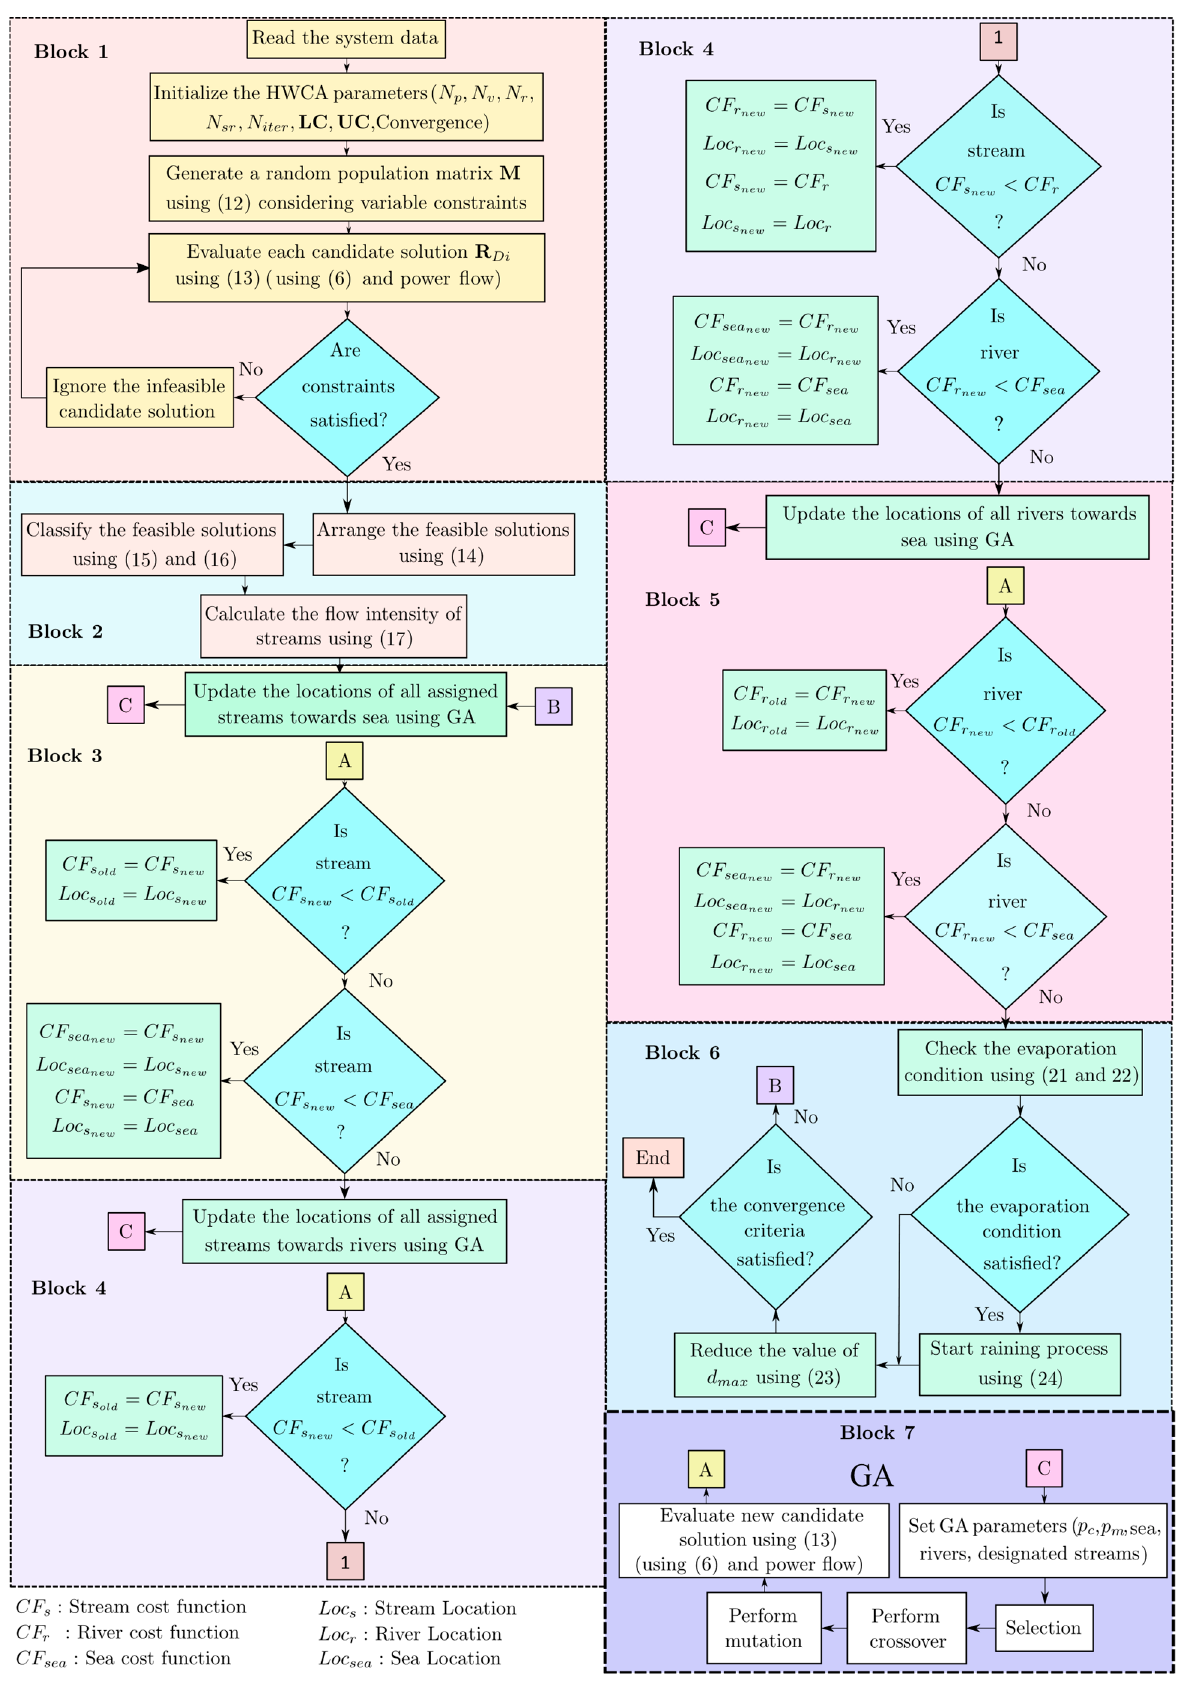
Figure 3. The flow chart of the proposed HWCA.